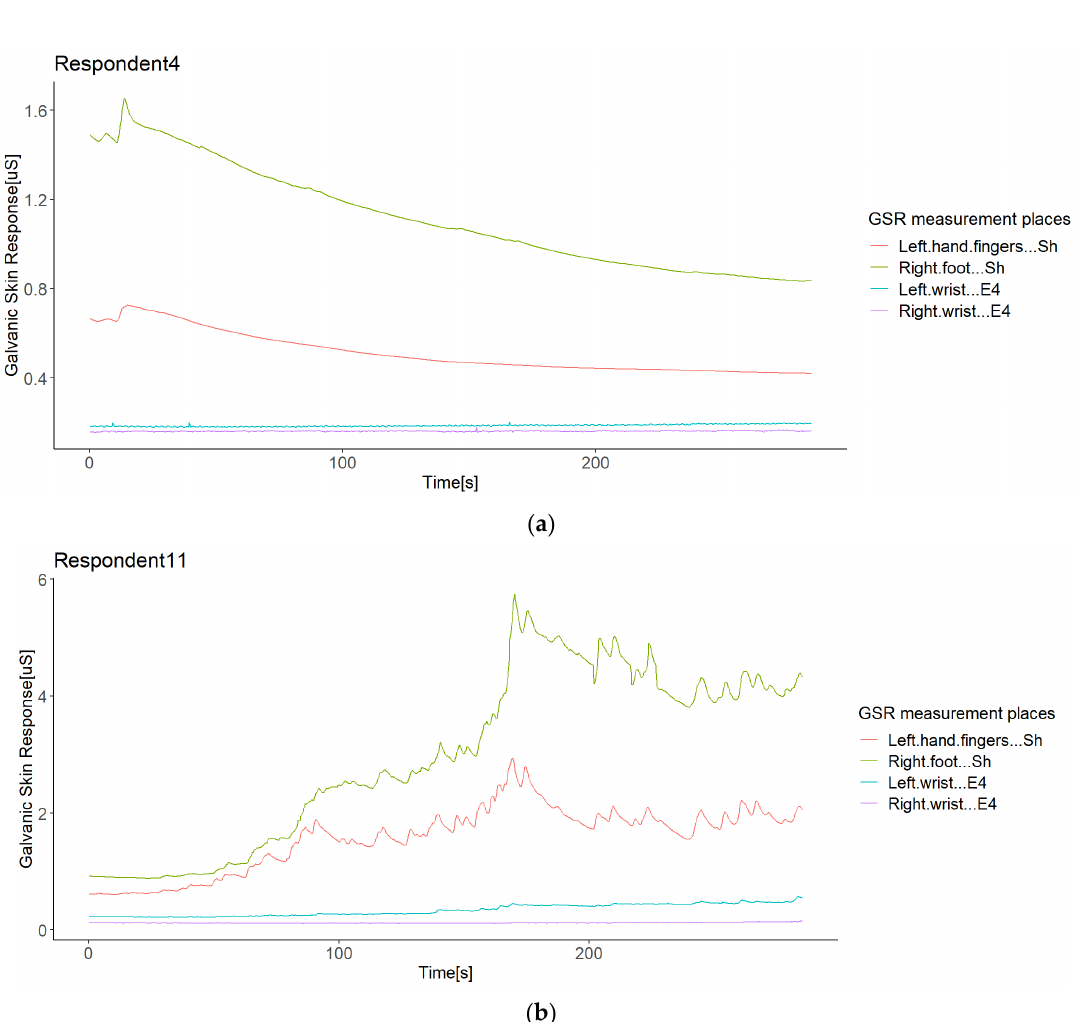
Figure 9. Illustration of the opposite directions of GSR signals in the same respondent (Respondent 4). A case of different types of sensors: A respondent with negative correlations between different sensors ( a ); a respondent with positive correlations between sensors ( b ).